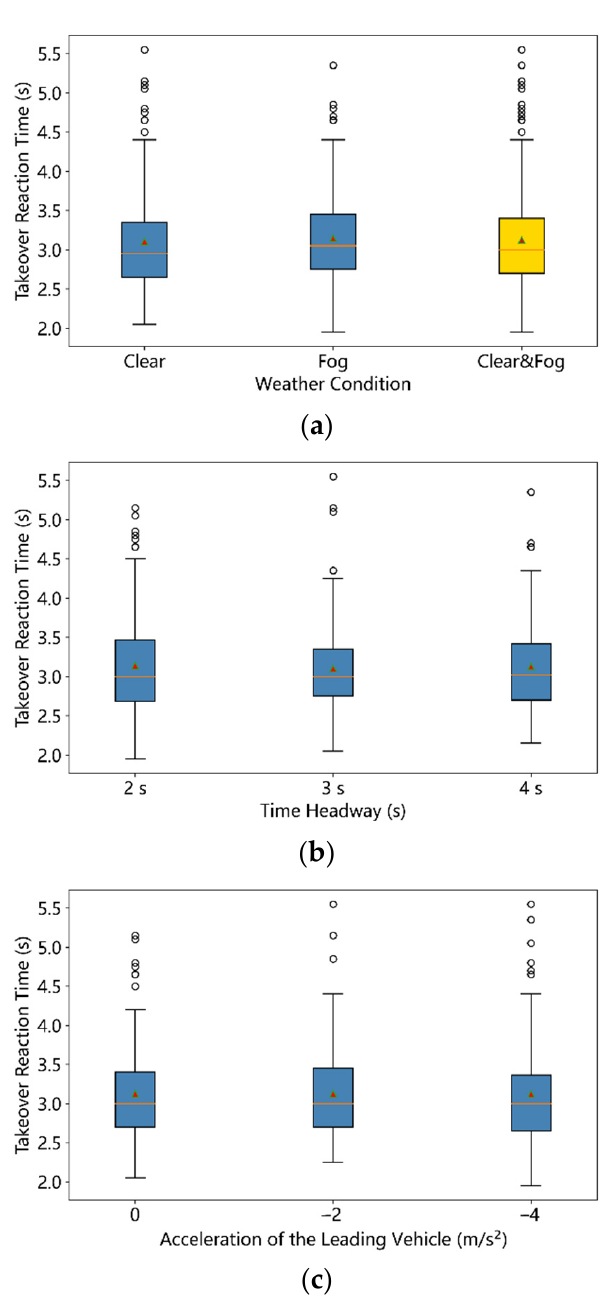
Figure 5. Boxplot of takeover reaction time of all 540 samples: ( a ) Weather Condition, ( b ) Time Headway, ( c ) Acceleration of the Leading Vehicle (the red triangle symbol denotes the mean value).